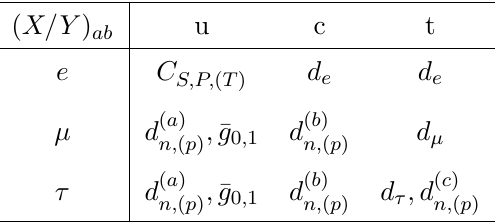
Table 5 . Dominant contributions at the hadronic level for each combination of lepton and quark in the R 2 and semileptonic S 1 scenarios. Note that all of the presently available observable classes give relevant constraints for at least one possible coupling. d ( a ) n denotes a contribution from the neutron EDM that stems from d e(cid:11) (and partly ~ d u ), d ( b ) n denotes a contribution via charm quark u EDM (or the Weinberg operator if the corresponding coe(cid:14)cient should turn out to be much smaller than its present central value) and d ( c ) n denotes a contribution from the Weinberg operator. (cid:22) g 0 ; 1 are completely dominated by ~ d u where they are relevant. Brackets indicate a contribution generically smaller than the dominant one(s), but only within a factor of 10. Where several entries are listed, their hierarchy might depend on the values of the corresponding hadronic matrix